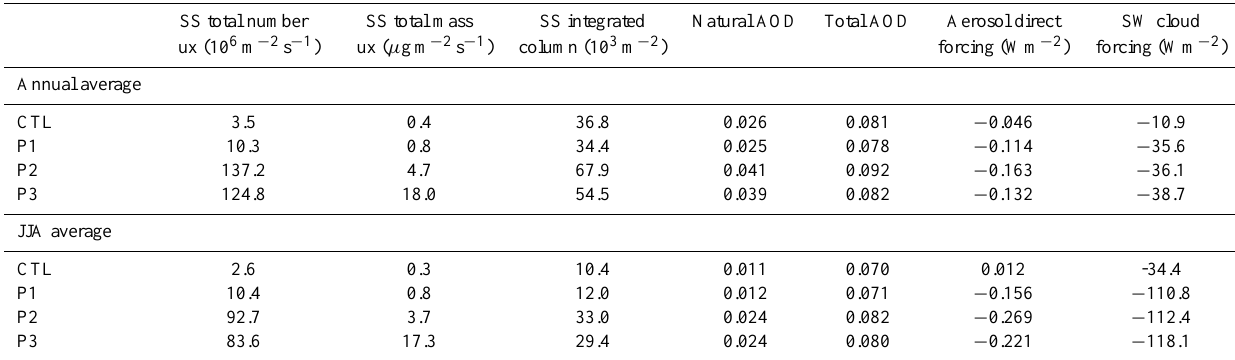
Table 4. CAM-Oslo results averaged between 80 and 90 ◦ N. The averaging includes ocean grid points only and covers the final five years of the model